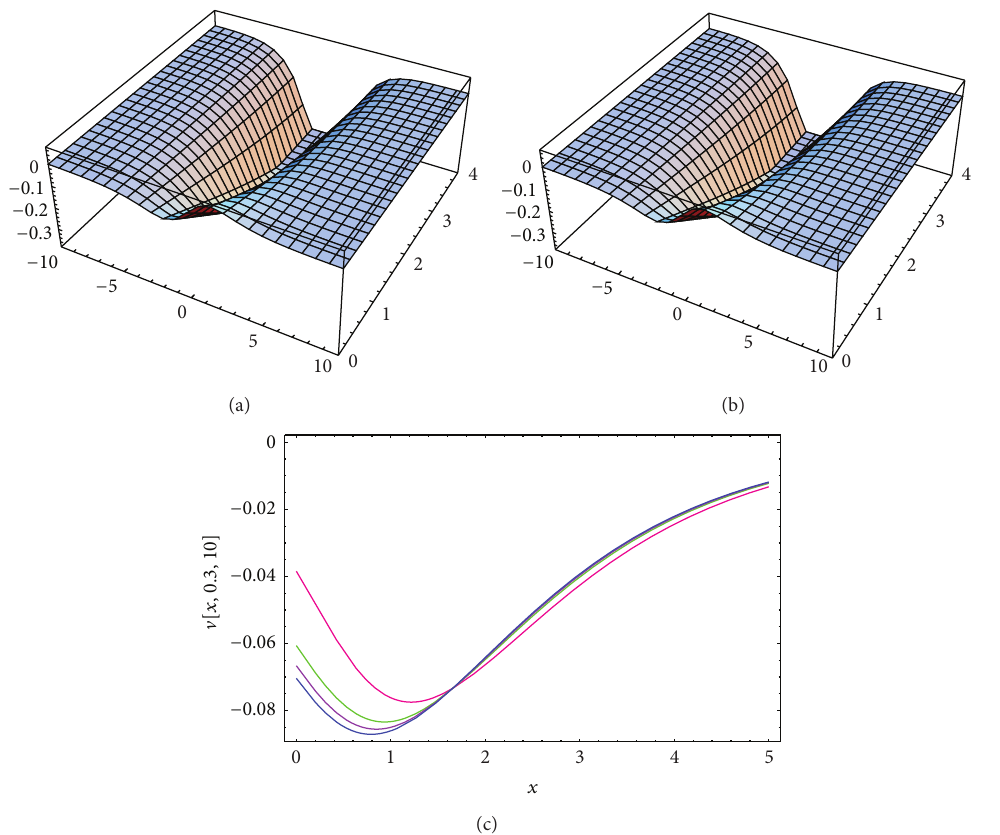
Figure 2: (a) and (b) The surface shows the solution V (𝑥,𝑦, 𝑡) for (8): (a) approximate solution for 𝛼 = 1.98, ℎ = −1.1 ; (b) exact solution. (c) Four profiles of approximate solutions V (𝑥,𝑦, 𝑡) for some values of 𝛼 : blue line ( 𝛼 = 2 ), mauve line ( 𝛼 = 1.9 ), green line ( 𝛼 = 1.8 ), and red line ( 𝛼 = 1.5 ), when 𝑘 1 = 0.1, 𝑘 2 = 0.03, 𝑘 3 = −0.3, 𝜎 = 𝐼 , and 𝜆 = 1